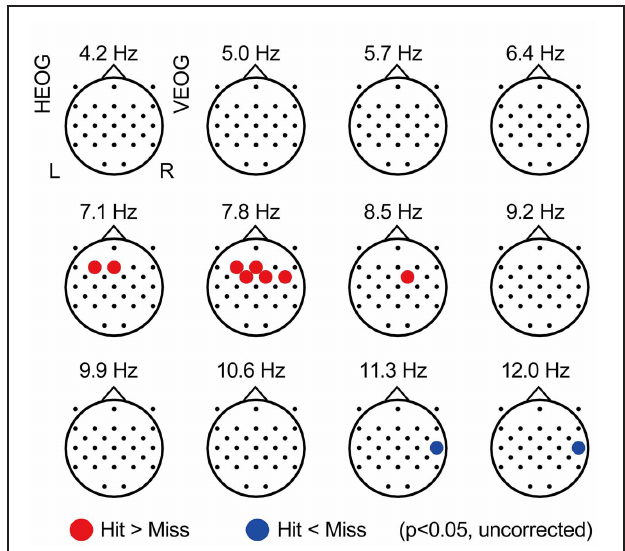
FIGURE 2 | Subsequently-recall related EEG power. Topographical maps showing average p -values comparing EEG power during encoding of subsequently recalled items (“Hit” condition) with that of not recalled items (“Miss” condition). Each point represents the electrode locations, in which the color indicates the change: red represents an increase in EEG power ( p < 0 . 05, uncorrected) and blue represents a decrease of EEG power ( p < 0 . 05, uncorrected). HEOG, horizontal electro-oculography; L, left; R, right; VEOG, vertical electro-oculography.